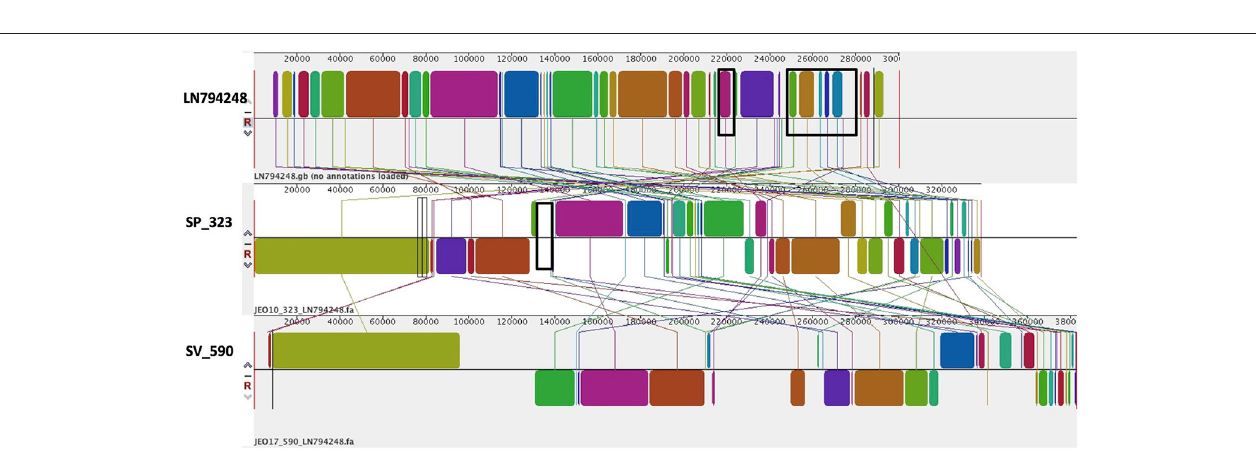
FIGURE 4 | Alignment of TrfA/IncHI2/IncHI2A plasmid homologs of Salmonella Virchow and Salmonella Poona to a reference plasmid LN794248. The alignment was created with MAUVE. The top row shows the reference plasmid, and the rows below the reconstructed plasmids in Salmonella Virchow and Salmonella Poona from the study. Each of the colored blocks outlines a region of the genome sequence that aligned to part of another genome, and is presumably homologous. Areas with no blocks were not aligned and contain sequence elements specific to a particular genome. Black boxes in the reference plasmid surround blocks found to contain antibiotic resistance genes strA, strB, blaTEM-1B, sul2, tet(A), blaCTX-M-15, aac(3)-Iia, catB3, aac(6’)Ib-cr, blaOXA-1 , and dfrA14 , which were present in S. Poona isolate from the study. The black box in the reconstructed plasmid in S. Poona indicates an insertion of QnrB1, which was absent in the reference